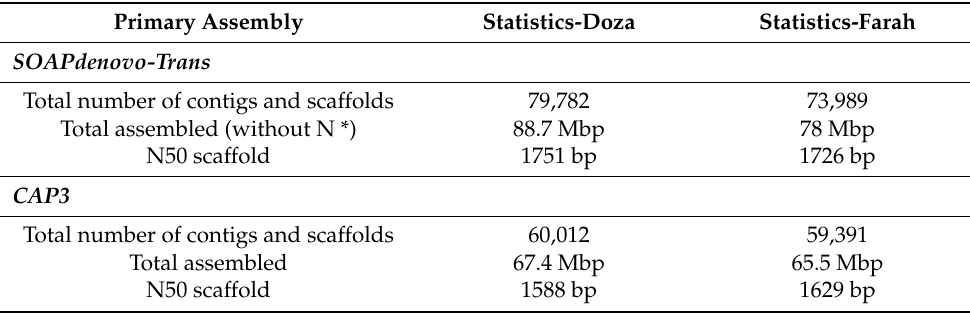
Table 2. Statistics of sequencing outputs and